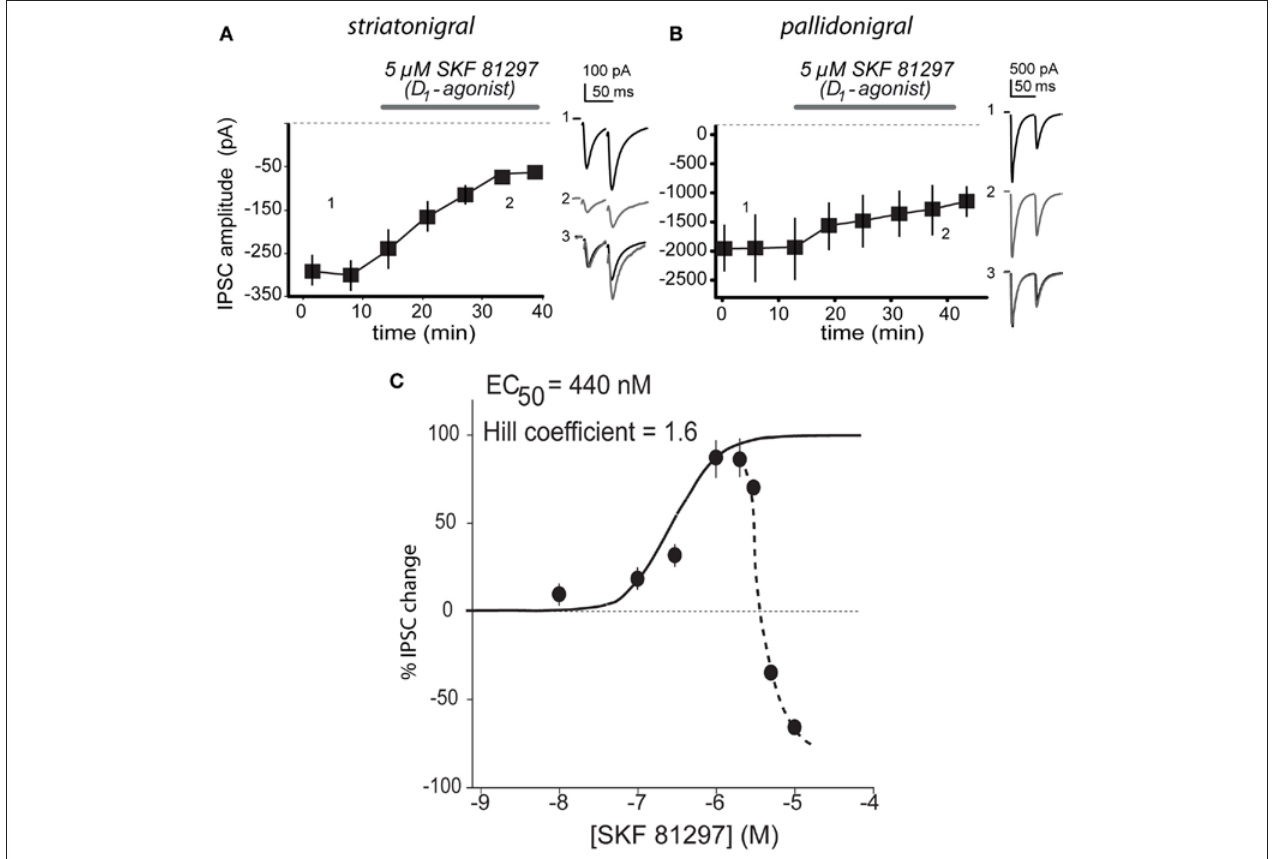
Figure 3 | Biphasic concentration–response relationship of D 5 μM SKF 81297 decreased IPSCs evoked from striatonigral terminals. (B) 5 μM SKF 81297 decreased IPSCs evoked from pallidonigral terminals. Record 3 in each frame is the superimposition of representative records 1 and 2 after normalization of the